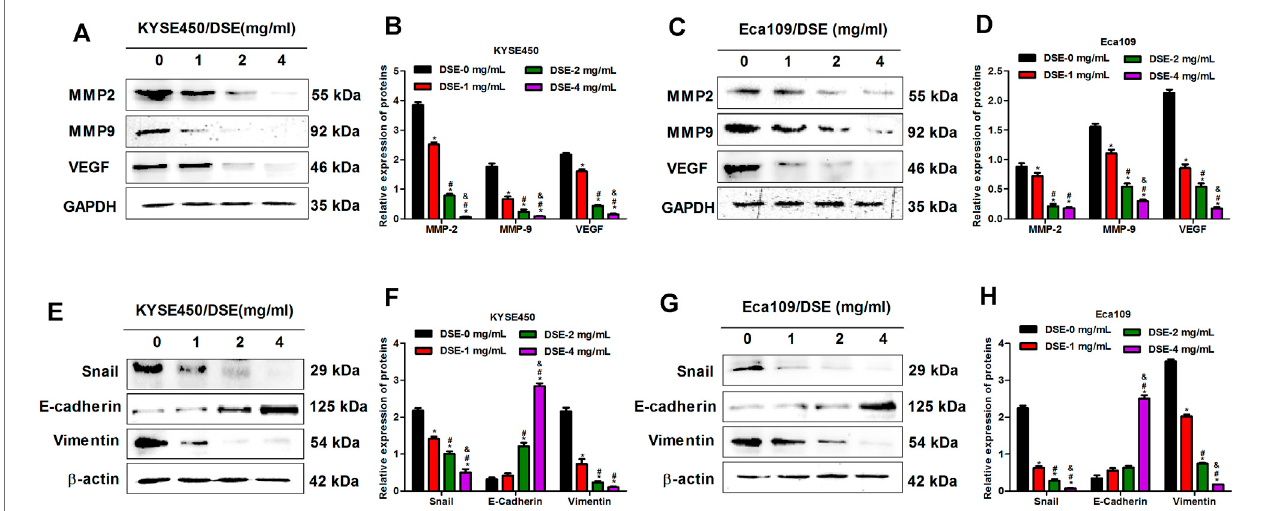
FIGURE 5 | DSE down-regulates MMP2, MMP9 and VEGF levels and inhibits EMT progression in human ESCC cells. (A – D) Effects of DSE on the expression of MMP2, MMP9 and VEGF proteins in KYSE450 and Eca109 cells. All data are expressed as mean ± standard deviation ( n = 3). * p < 0.05 vs. 0 mg/ml DSE group. # p < 0.05 vs. 1 mg/ml DSE group. & p < 0.05 vs. 2 mg/ml group. (E – H) Effects of DSE on the expression of EMT related proteins in KYSE450 and Eca109 cells. All data are expressed as mean ± standard deviation ( n = 3). * p < 0.05 vs. 0 mg/ml DSE group. # p < 0.05 vs. 1 mg/ml DSE group. & p < 0.05 vs. 2 mg/ml